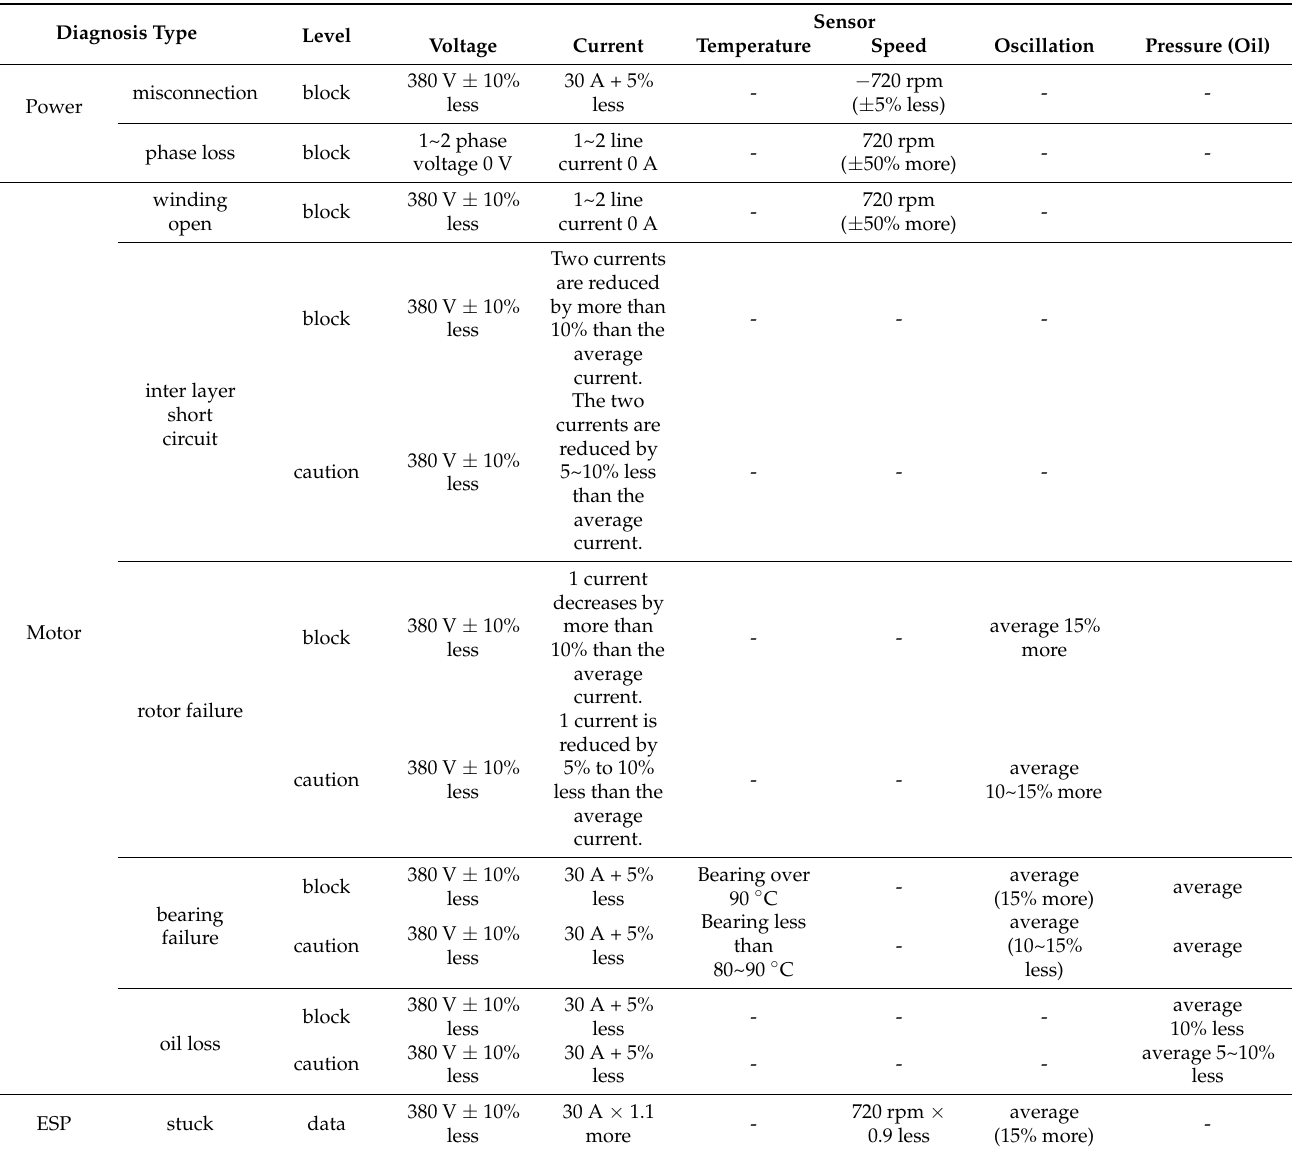
Table 3. Judgment Criteria for Composite